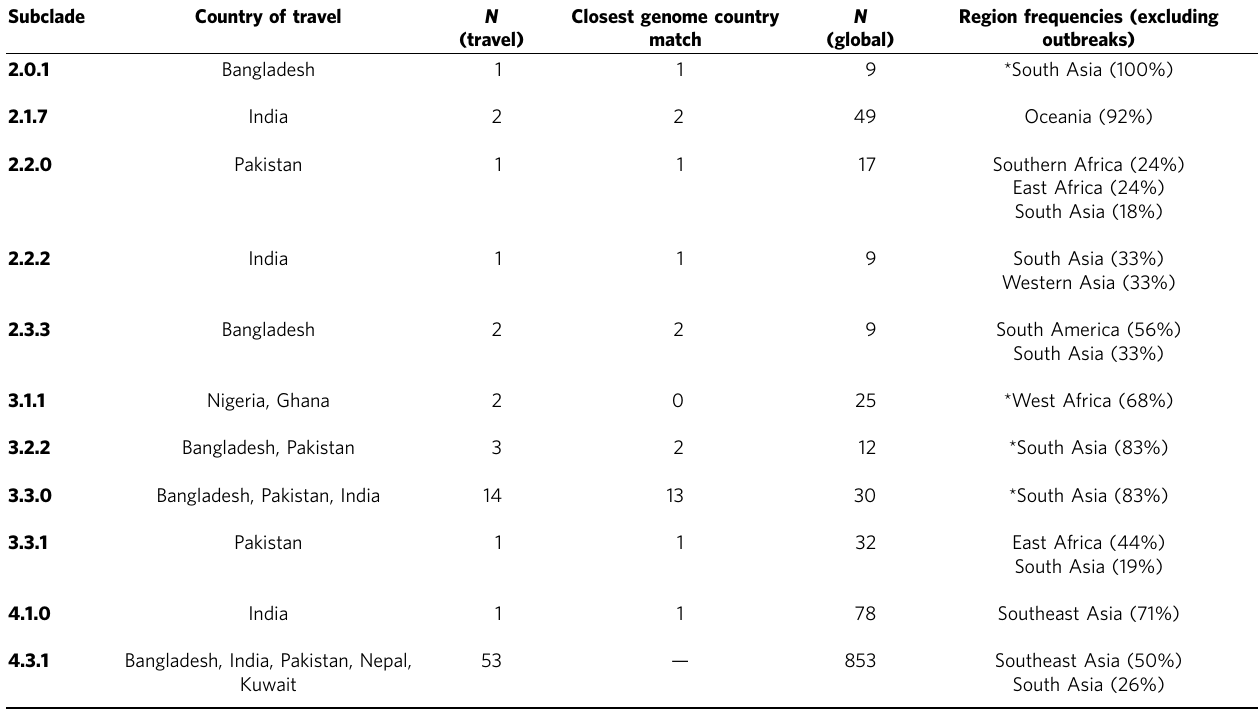
Table 3 | Summary of genotyping and SNP results for travel-associated S. Typhi isolates with known country of travel. Subclade